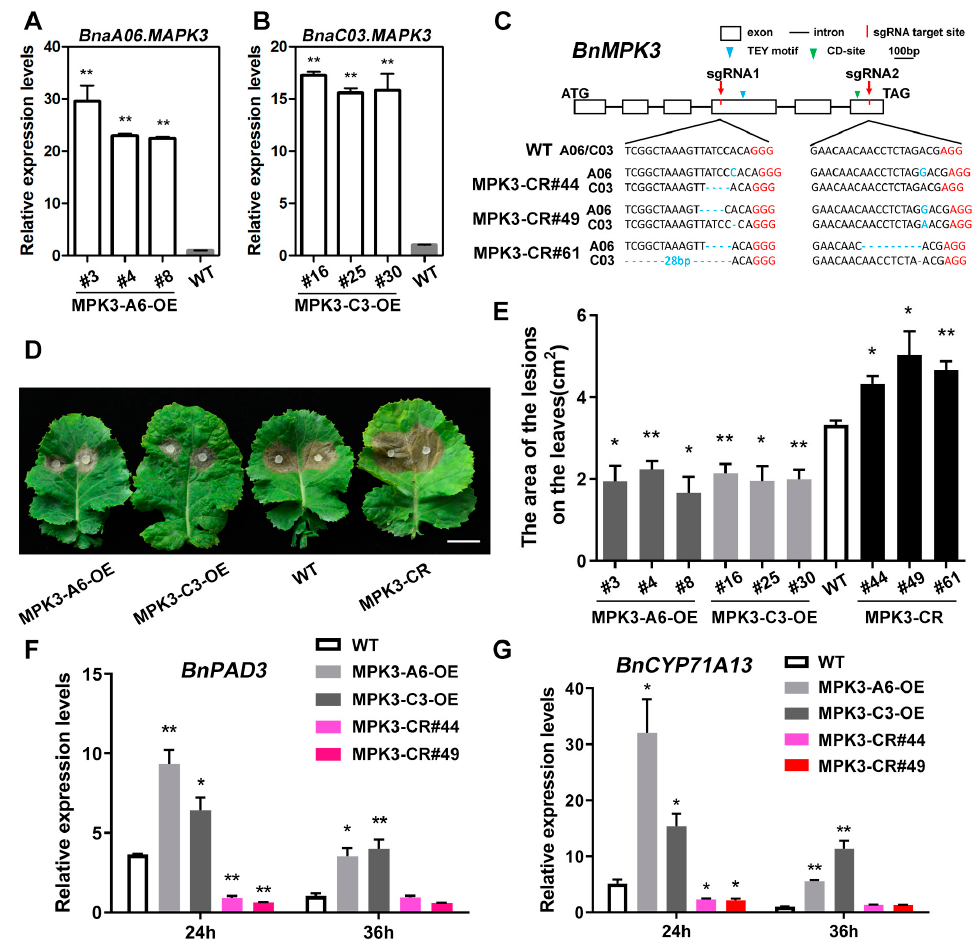
Figure 6. Contribution of BnMPK3 to S. sclerotiorum resistance in B. napus. ( A , B ) BnaA06.MPK3 overexpression (MPK3-A6-OE) lines ( A ) and BnaC03.MPK3 overexpression (MPK3-C3-OE) lines ( B ) established using qRT-PCR analysis. The expression in WT plants as control. Data are shown as means ± SD ( n = 3). Asterisks indicate significant differences compared with WT plants ( t -test, ** p < 0.01). ( C ) A schematic diagram to show the characterization of the BnMPK3 exon/intron sequence and the target sites of sgRNAs. The edit types of three independent homozygous mutants (MPK3-CR#44, 49, and 61) are shown. The protospacer-adjacent motifs (PAM) are marked in red. TEY motif, phosphorylated by MKKs; CD-site, interacts with MKKs; ATG, start codon; TAG, stop codon. ( D ) Photographs of the lesions of detached leaves from BnMPK3 transgenic lines and WT plants in approximately 4 weeks when inoculated with 7 mm S. sclerotiorum hyphae agar block at 22 °C for 48 h. Scale bar, 2 cm. ( E ) Statistical analysis of the lesion areas of BnMPK3 transgenic lines and WT plants after 48 h inoculation. Data are shown as means ± SD ( n = 3). Asterisks indicate significant differences compared with WT ( t -test, * p < 0.05, ** p < 0.01). ( F , G ) Relative expression levels of two camalexin biosynthesis-related genes, BnPAD3 and BnCYP71A13 , in BnMPK3 transgenic lines and WT plants after S. sclerotiorum inoculation for 24 h or 36 h. Data are shown as means ± SD ( n = 3). Asterisks indicate significant differences compared with WT at corresponding time points ( t -test, * p < 0.05, ** p < 0.01).